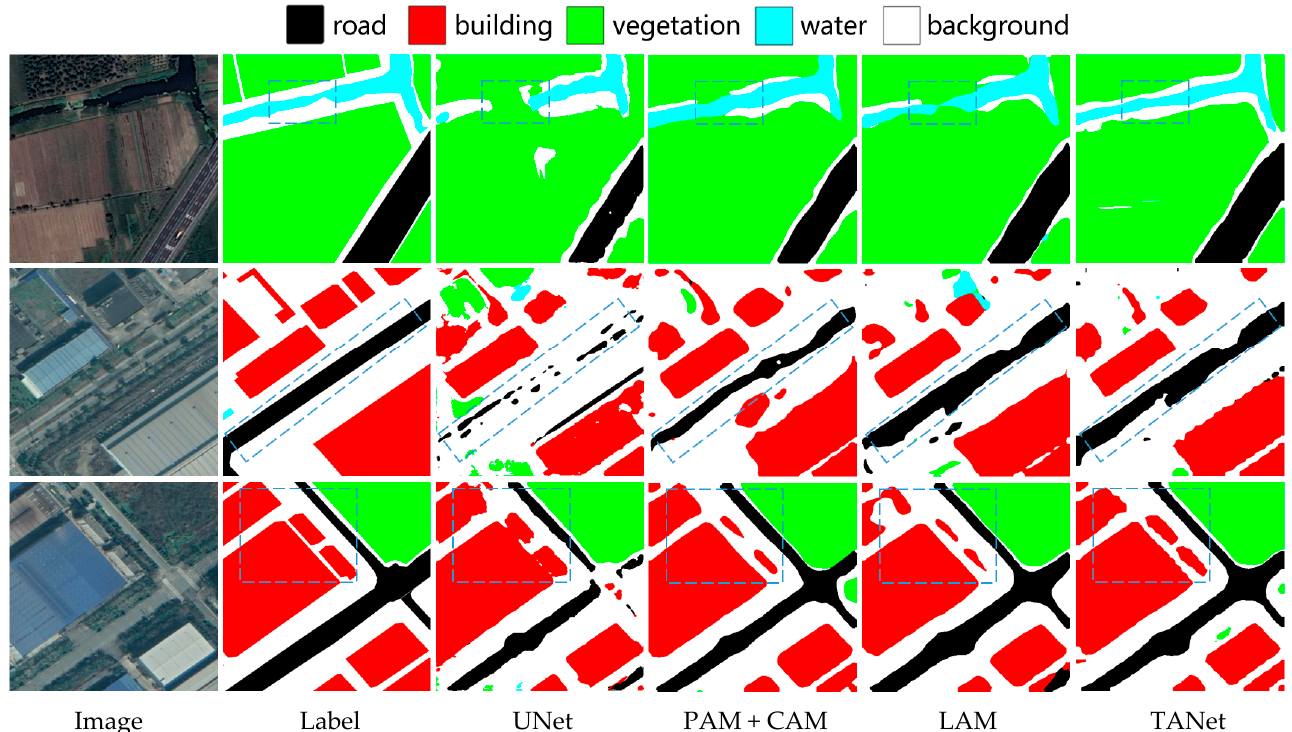
Figure 9. Examples of semantic segmentation results on ablation study of triple attention modules (CZ-WZ dataset).